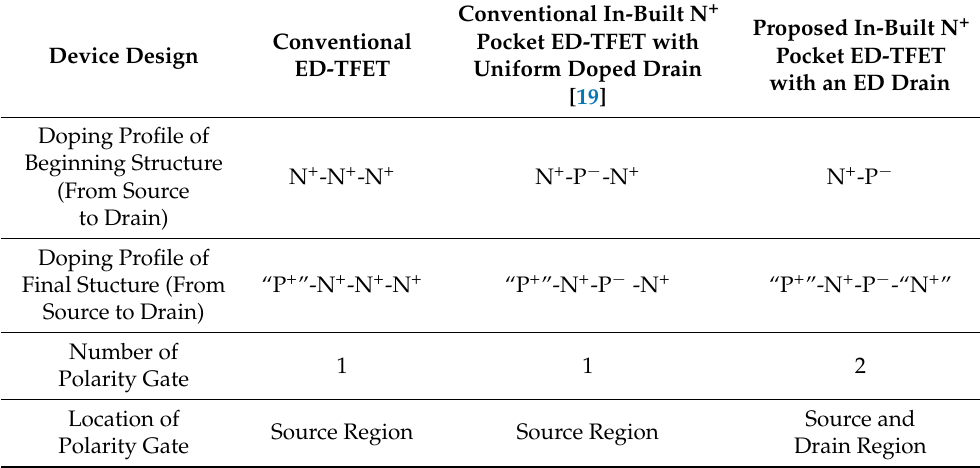
Table 1. Comparison of device